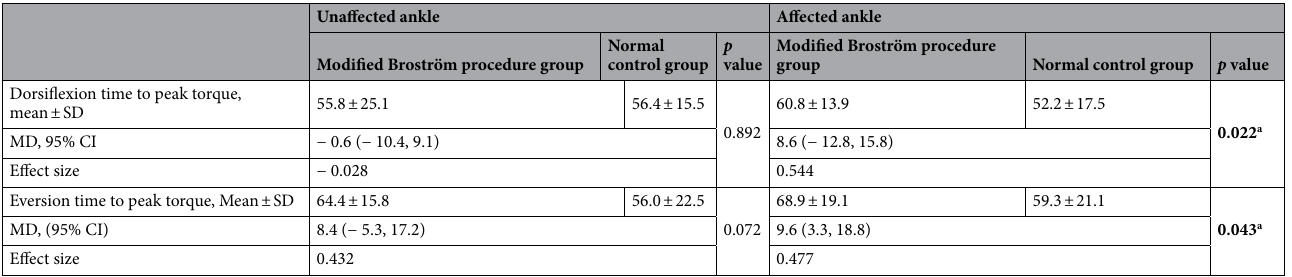
Table 3. Time to peak torque between the modified Broström procedure and normal control groups. Significant values are in bold. Values expressed as mean ± standard deviation. The measurement units for time to peak torque tests was the millisecond. SD Standard deviation, MD mean difference, CI confidence interval. a Statistically